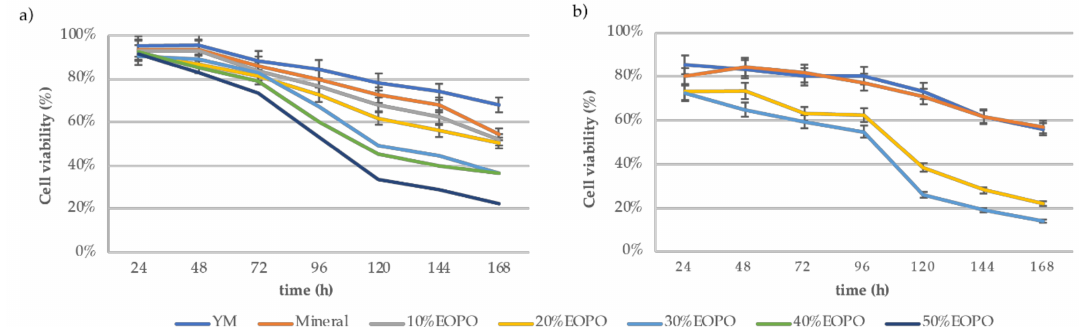
Figure 2. Cell viability in submerged fermentation of Rhodotorula mucilaginosa UANL-001L cultures in presence of ( a ) EOPO 970 or ( b ) EOPO 12,000. Cultures were maintained in liquid medium on sterile conditions and kept in incubation for 3 days at 30 ◦ C and 250 rpm.